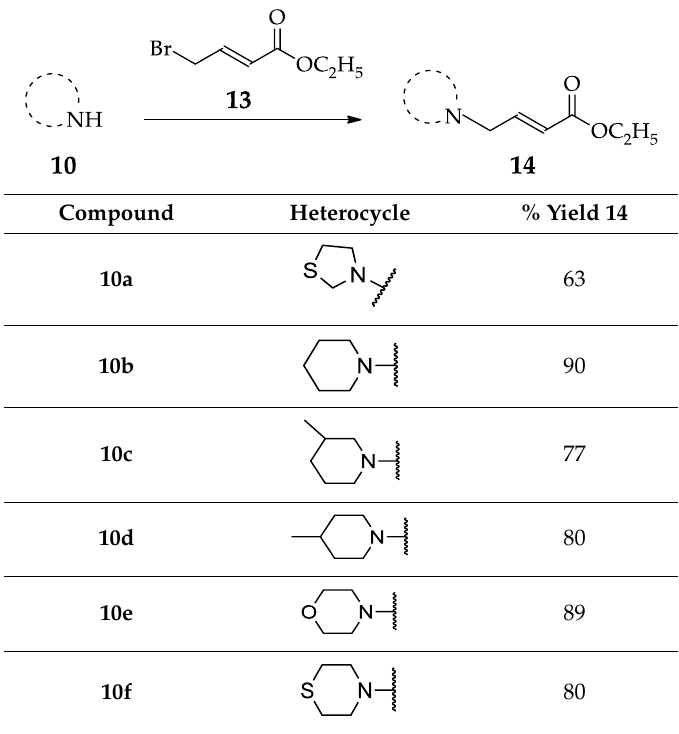
Table 3. Synthesis of the β -substituted analogues 8 .